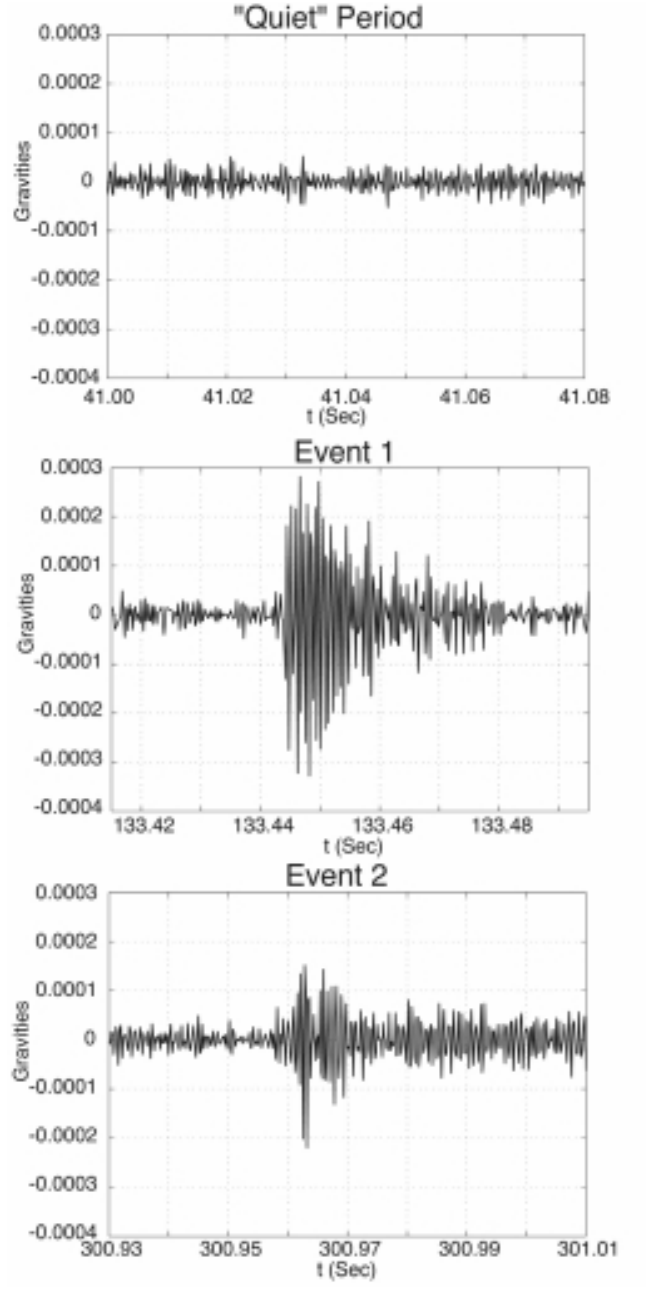
Fig. 4. Detail of Accelerometer Response during Thermal Excitation Period at Node 3004 in the Z-Direction (High-pass Filtered above 100 Hz). above protocol, two dynamic events were identified during this period, designated Event 1 and Event 2. It should be noted that the persistent motion in this data set is not sensor noise, but vibration of the boom. A detail of a period of persistent motion, or “quiet” period, along with details of Events 1 and 2 are shown in Fig. 4. The data shown in Figs 3 and 4 are band-pass filtered between 1100 and 2000